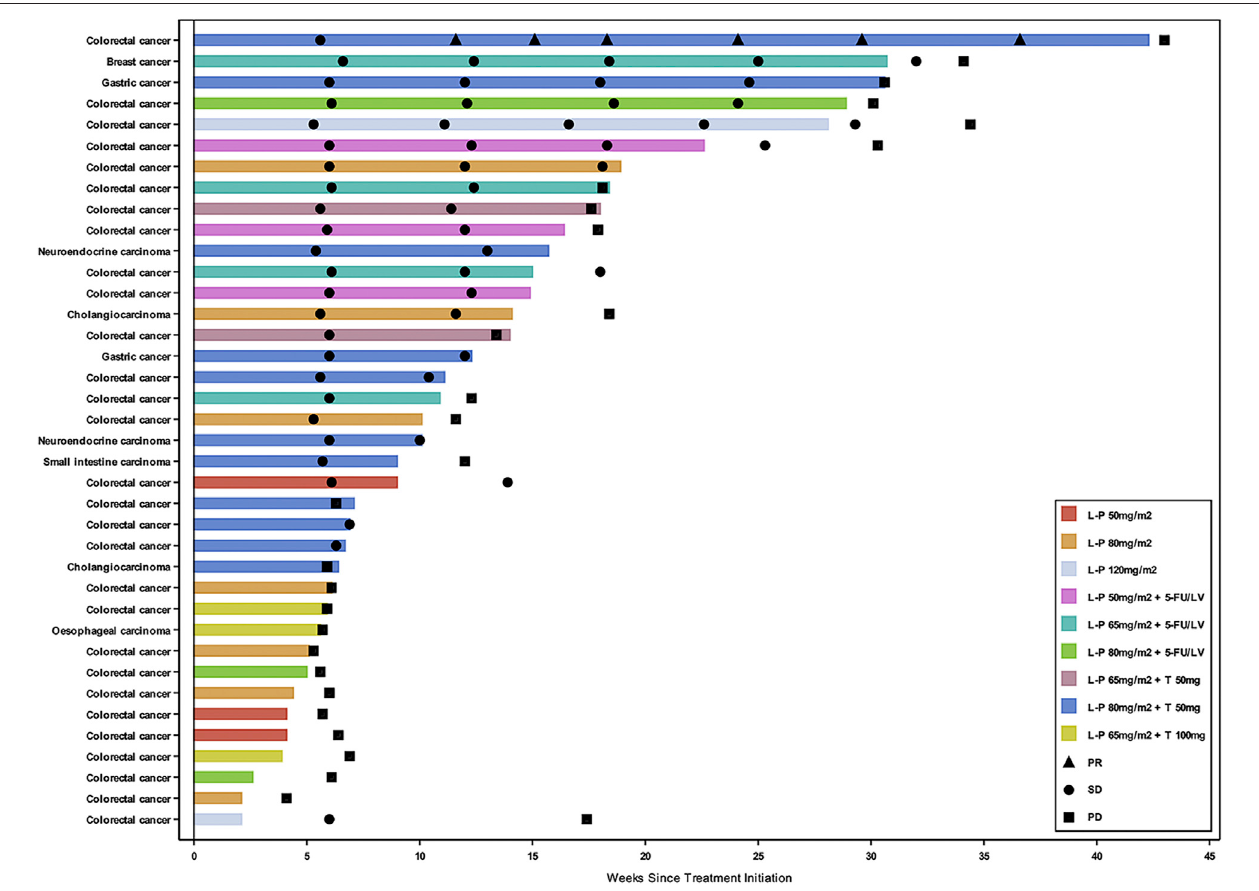
FIGURE 2 | Swimmer plot by cancer type and dose level. Three patients who had clinical deterioration before an initial response assessment were excluded from the swimmer plot. Response assessment was performed in according to the Response Evaluation Criteria in Solid Tumors version 1.1. L-P, simmitecan; 5-FU/LV, 5- fl uorouracil/leucovorin; T, thalidomide; PR, partial response; SD, stable disease; PD, progressive disease.